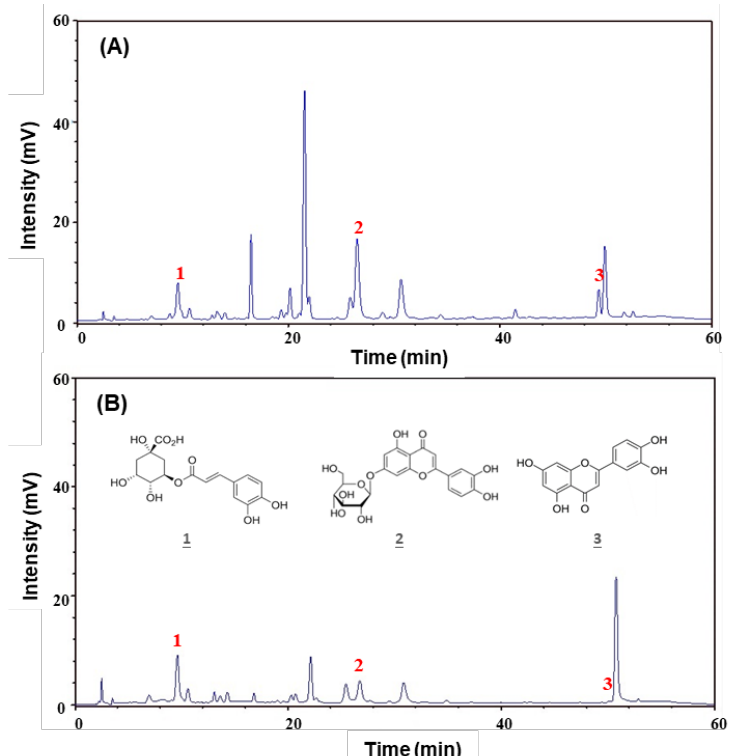
Molecules 2020 , 25 , x FOR PEER REVIEW 10 of 17 Figure 6. HPLC chromatogram of the GTE ( A ) and GTW ( B ). Identified components: 1: chlorogenic acid; 2: luteolin-7-glucoside; and 3: luteolin. Table 1. Main ingredients analysis of the GT extracts.